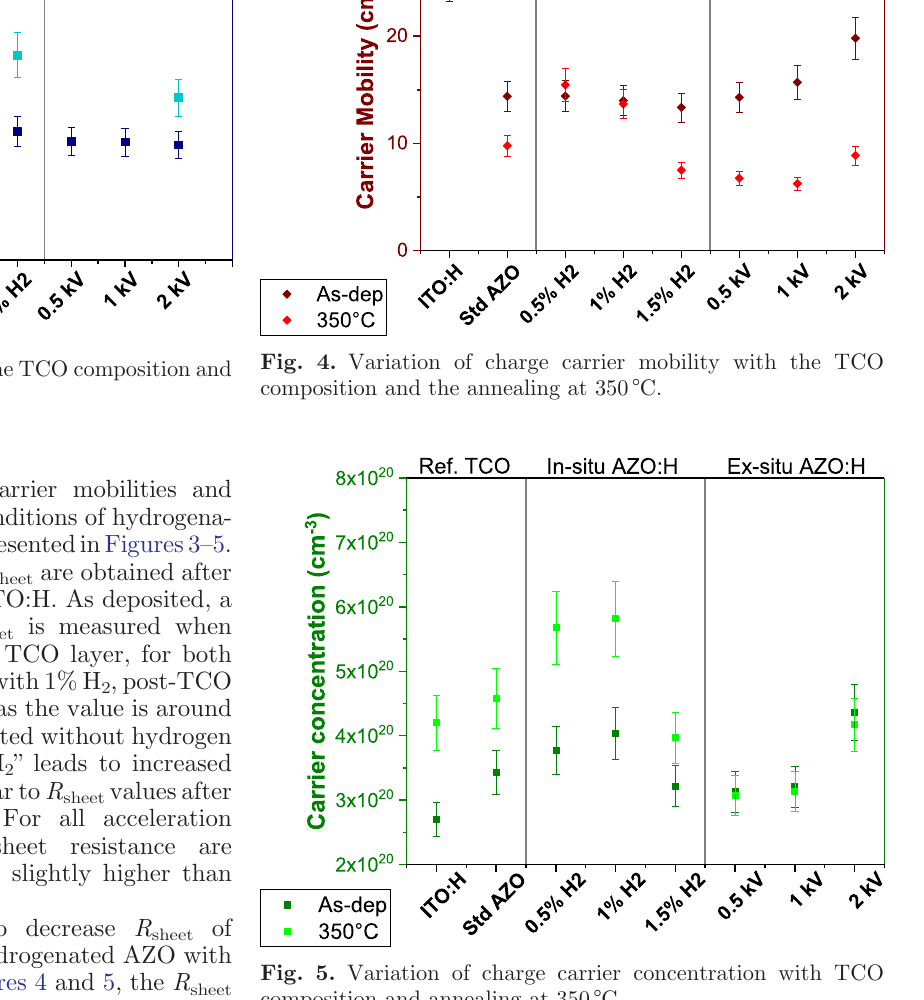
Fig. 5. Variation of charge carrier concentration with TCO composition and annealing at 350 °